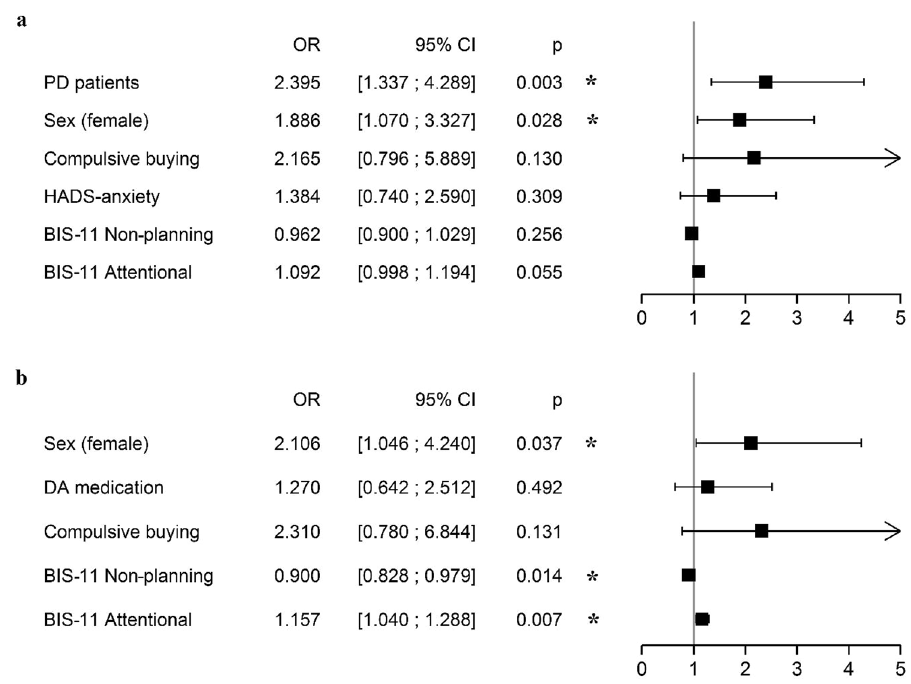
Figure 1. Multivariate analysis of food addiction (FA): a in the whole population (n = 400) and b in PD population (n = 200). BIS-11 Non-planning Barratt impulsiveness scale subscore non-planning, BIS-11 Attentional Barratt impulsiveness scale subscore attentional, CI confidence interval, DA medication dopamine agonist medication, HADS-anxiety hospital anxiety and depression scale subscore anxiety, OR odds ratio, PD Parkinson’s